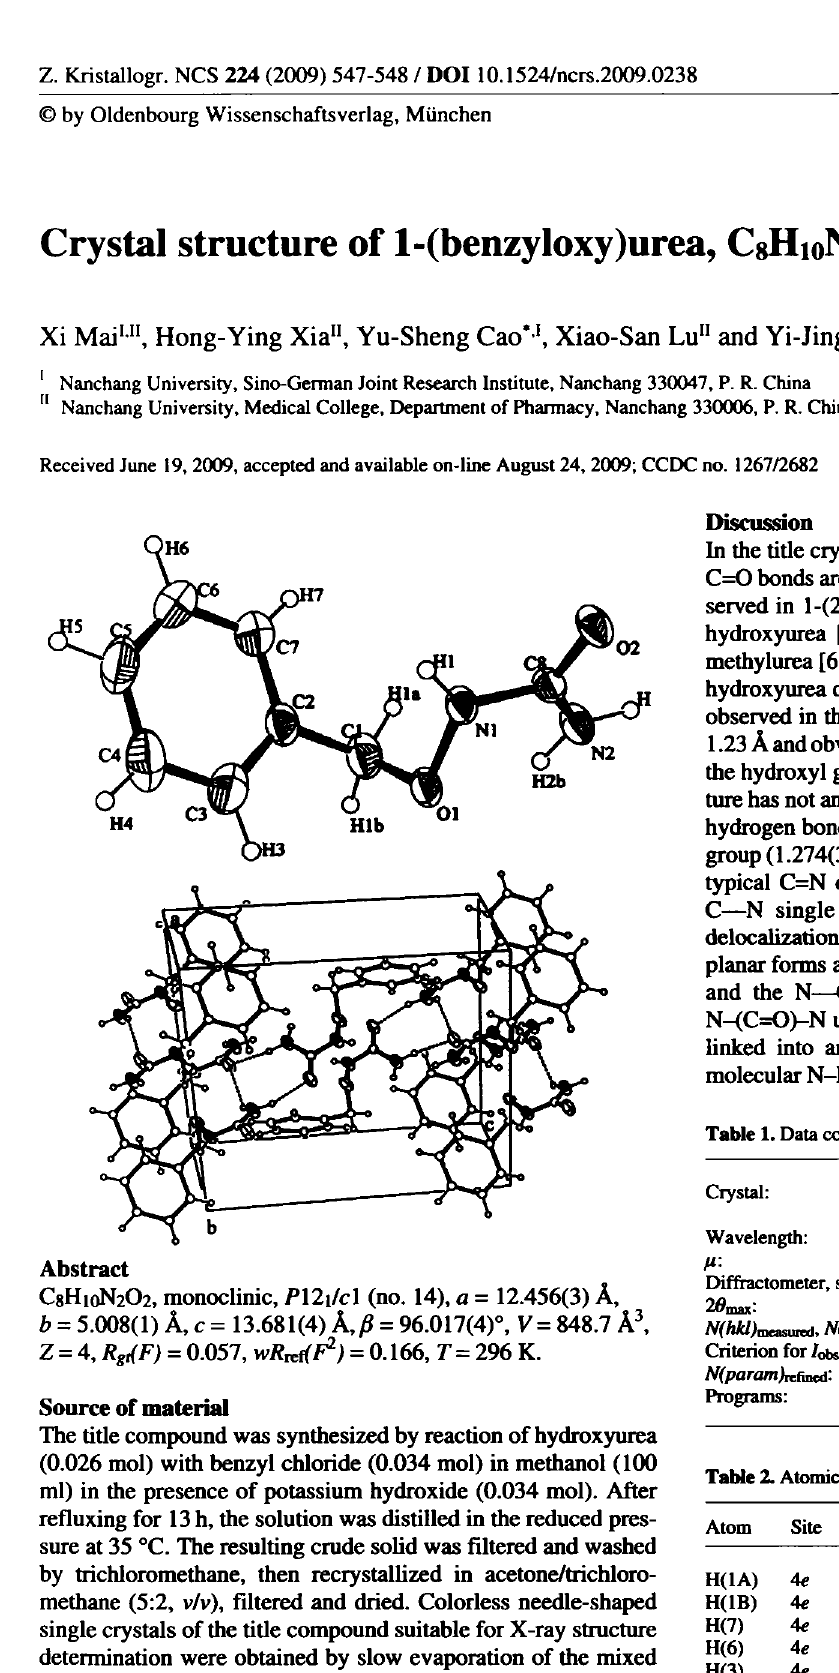
Table 2. Atomic coordinates and displacement parameters (in Ä 2